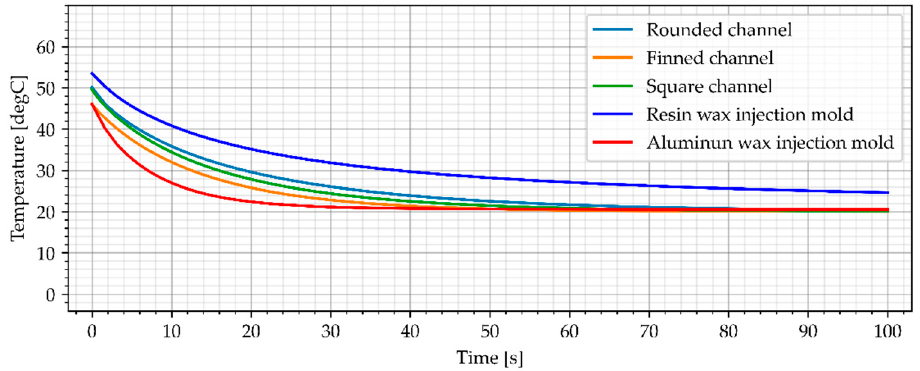
Figure 17. The average temperature of the sample.